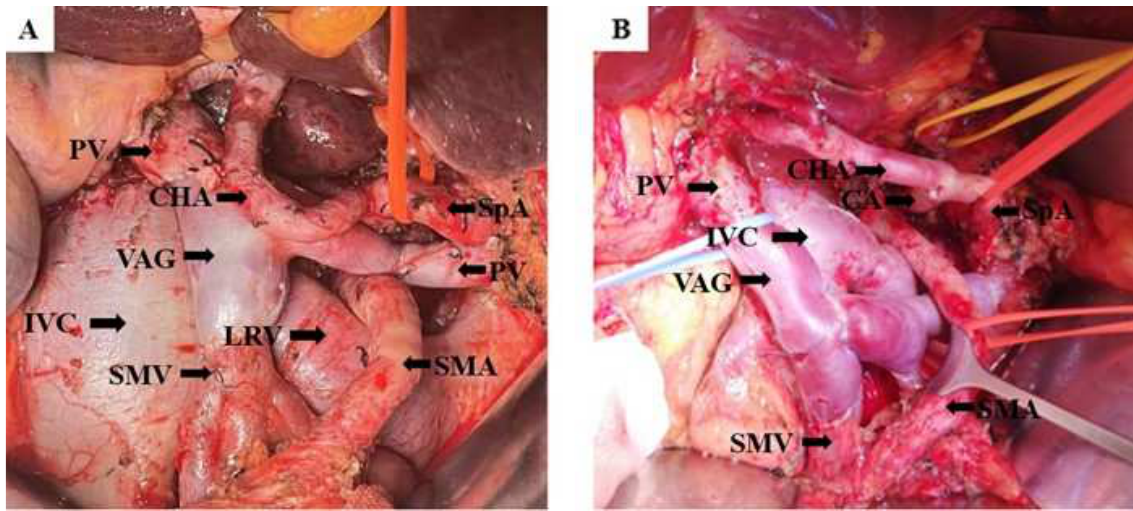
Figure 1. Intraoperative pictures of the portal vein reconstruction. ( A ) Intraoperative picture of patients in Group 1; ( B ) Intraoperative picture of the patients in Group 2. Abbreviations: CA, celiac axis. CHA, common hepatic artery. IVC, inferior vena cava. LRV, left renal vein. PV, portal vein. SMV, superior mesenteric vein. SMA, superior mesenteric artery. SpA, splenic artery. VAG, venous